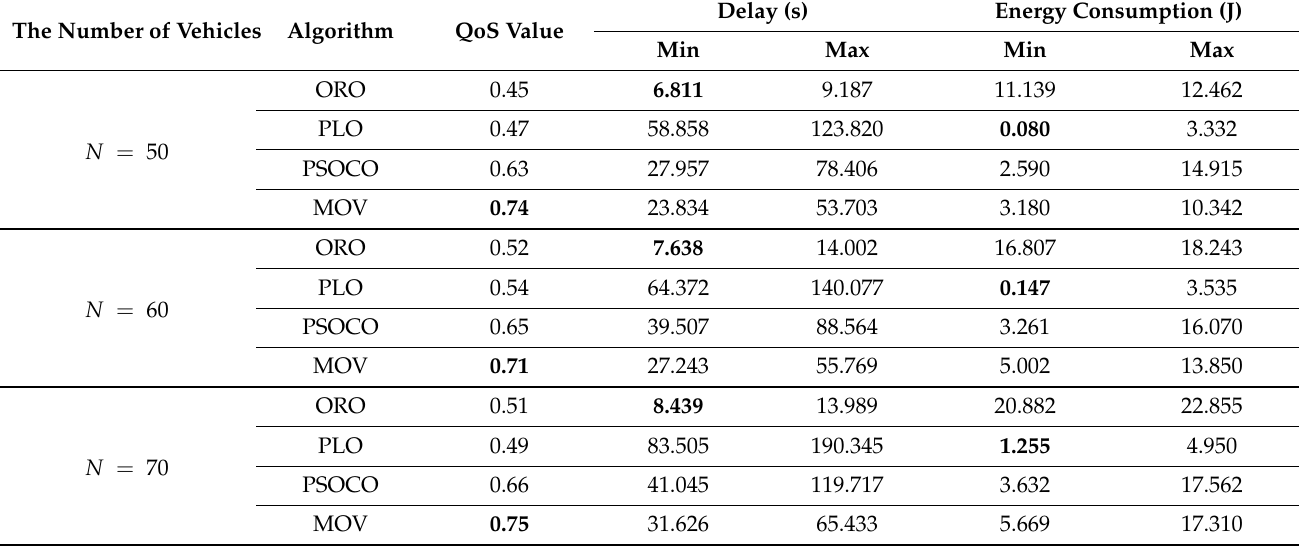
Table 3. The values of indicators using different algorithms obtained with different numbers of vehicles.